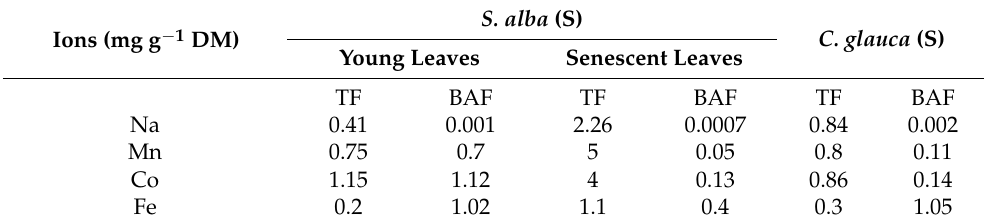
Table 3. Bioaccumulation factor (BAF) and translocation factor (TF) in seedlings of C. glauca (S, stress) and S. alba (S, stress) treated with 25% industrial wastewater (S, stressed treatment) over 35 days.